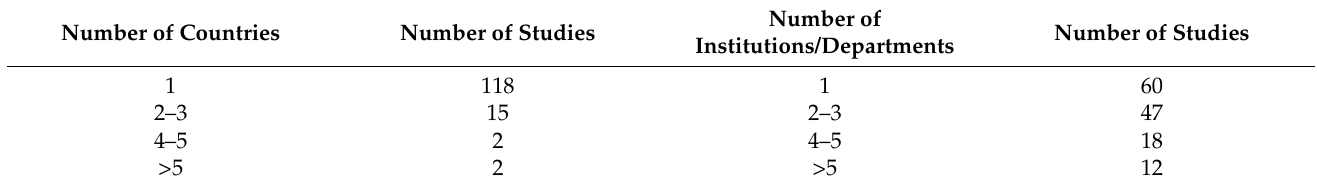
Table 4. Research degree of internationalization and interdisciplinarity.